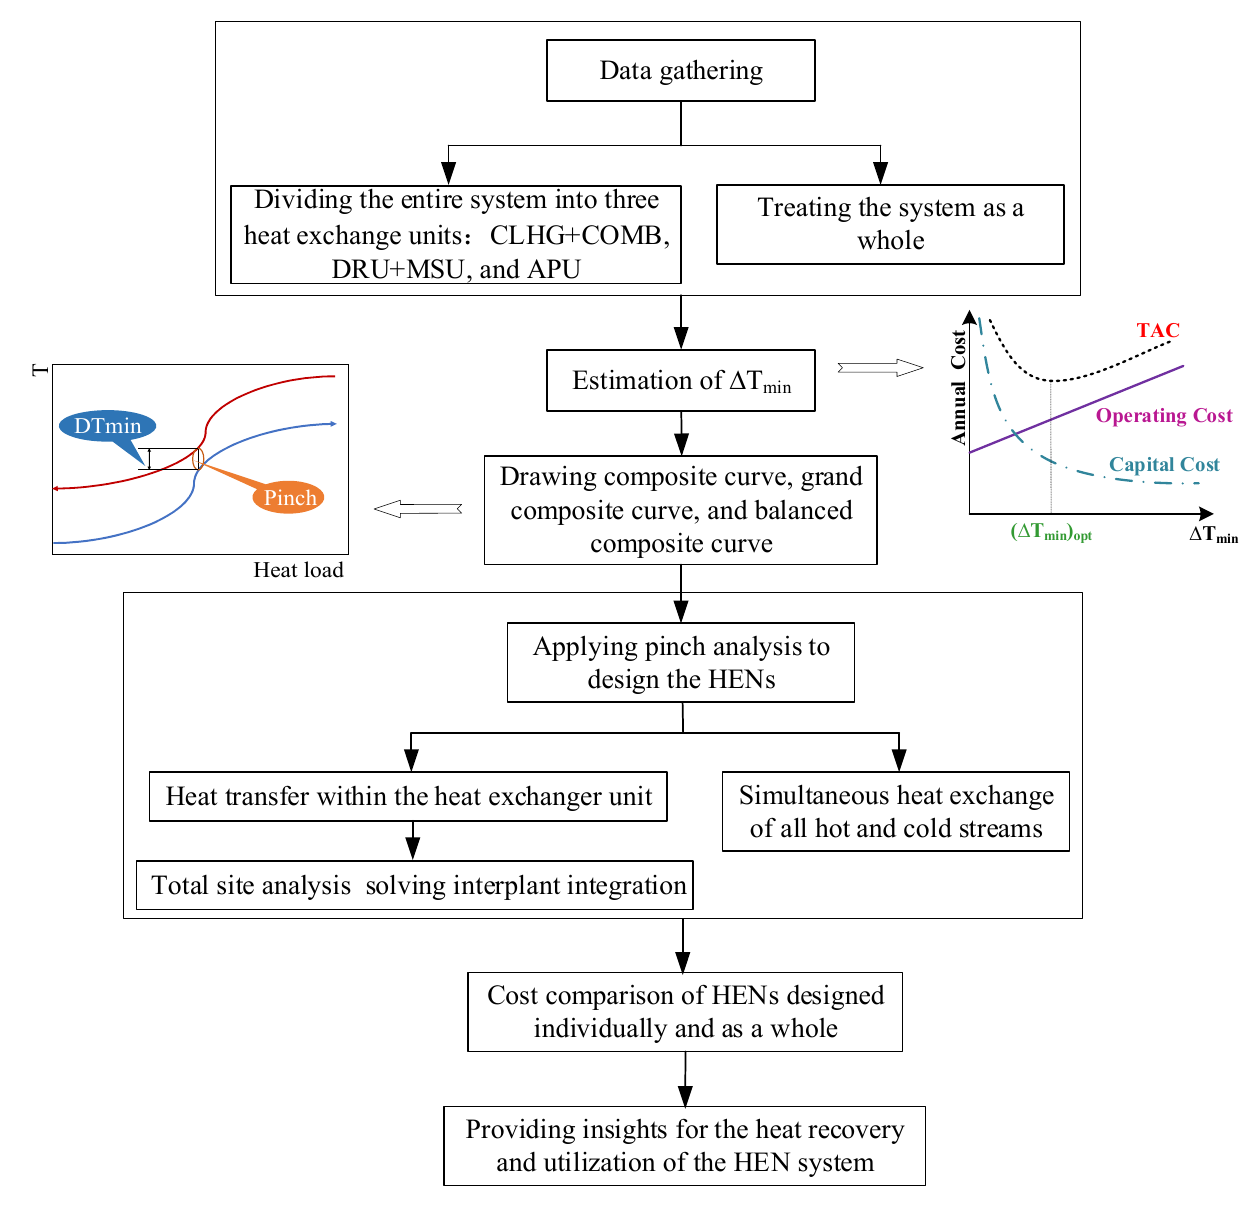
Figure 2. Flowchart of energy integration framework.